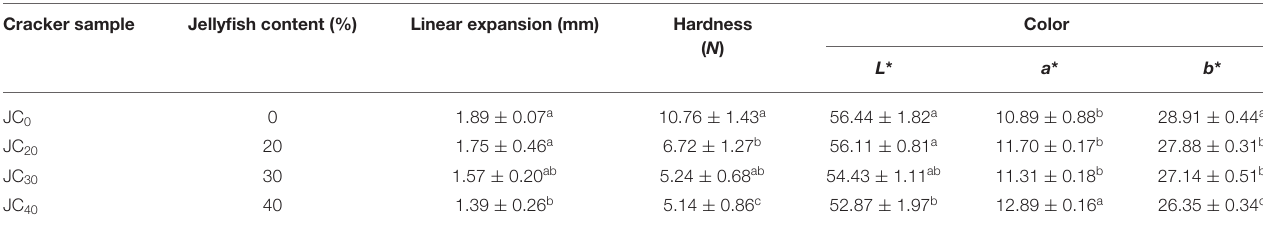
* Mean ± standard deviation values in the same column for each sample followed by different letters are significantly different (p ≤ 0.05).